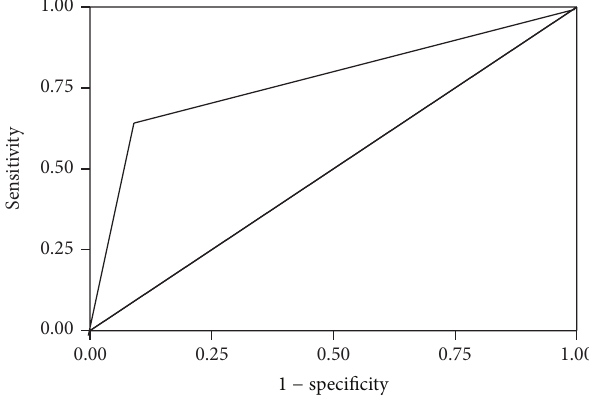
Figure 1: ROC curve of serum FGF21 concentrations for occurrence of diabetic retinopathy. The estimated cut-off value of FGF21 is 550 pg/mL, with 86.5% sensitivity and 75% specificity for the existence of diabetic retinopathy (area under the curve = 0.776, 𝑃 > 0.05 ). Diagonal segments were produced by ties.